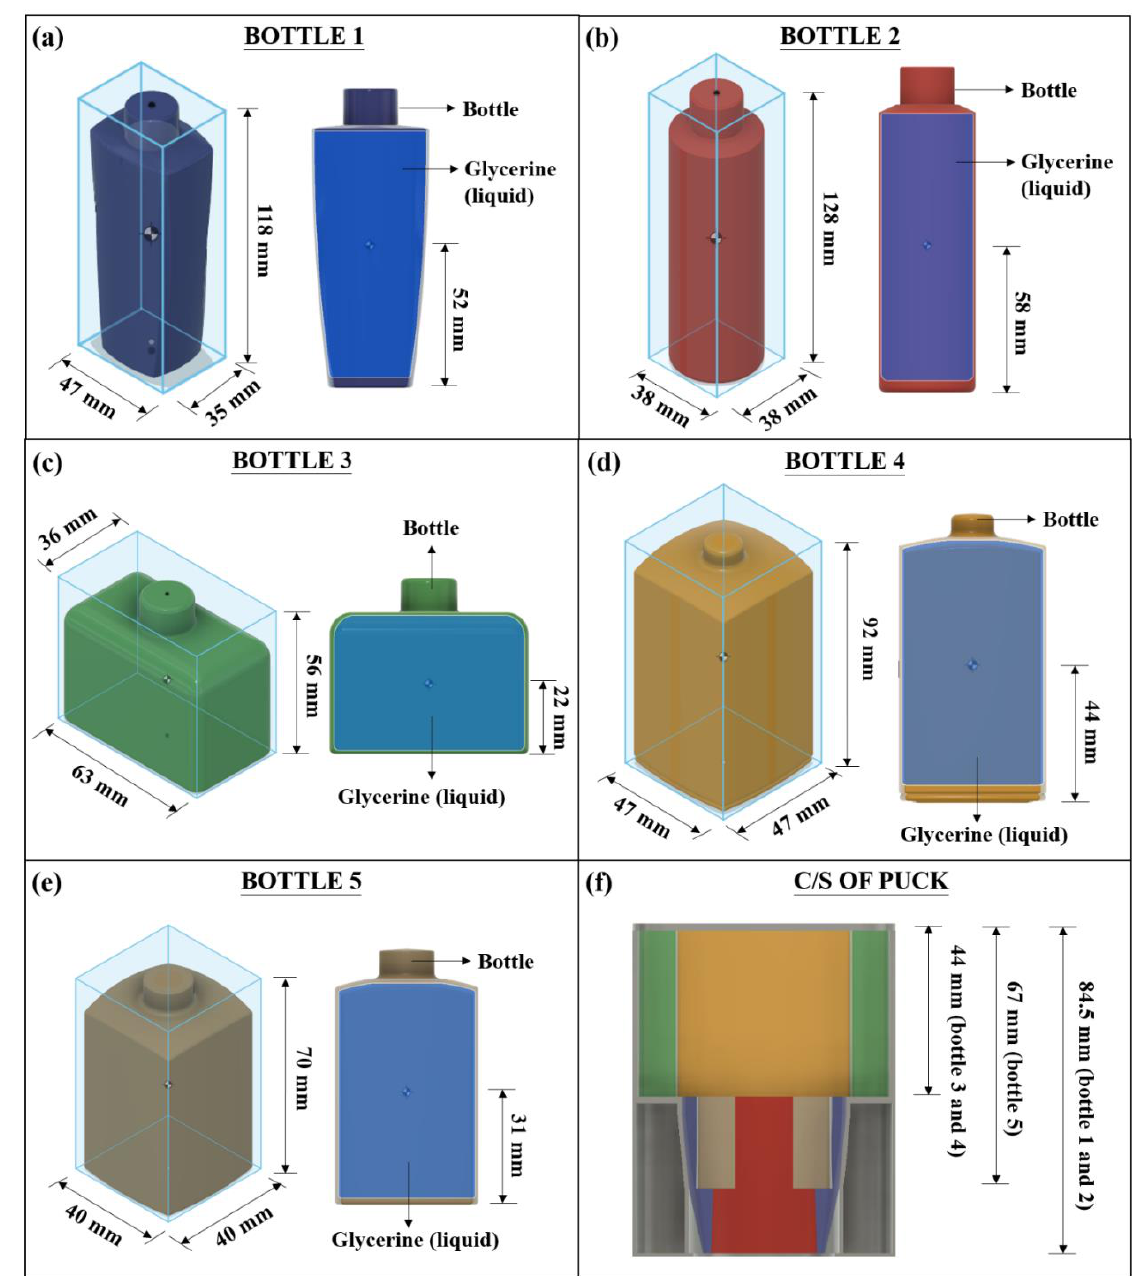
Figure 8. Dimensional details of designed bottles and their Center of Mass (COM) ( a – e ) and cross- section of the universal puck carved to hold different bottles ( f ).